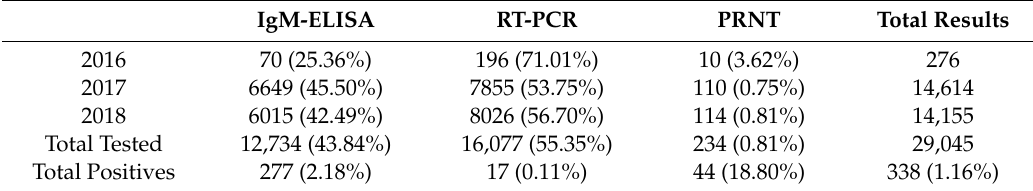
Table 1. Zika virus testing by test type, 2016–2018. This table depicts testing by test type and total positives by test type. Plaque-reducing neutralization testing (PRNT) took place for IgM non-negative specimens. IgM samples had a 2.18% positivity rate, while RT-PCR samples had a 0.11% positivity rate. Overall positivity rate for these specimens was 1.16%.